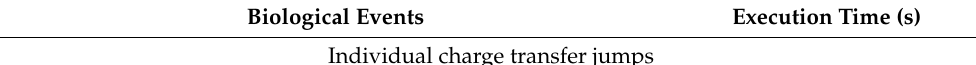
Table 1. Transition times in biological reactions cover frequencies from 0.5 Hz to 333 GHz, much faster than IEEE’s RFR integration